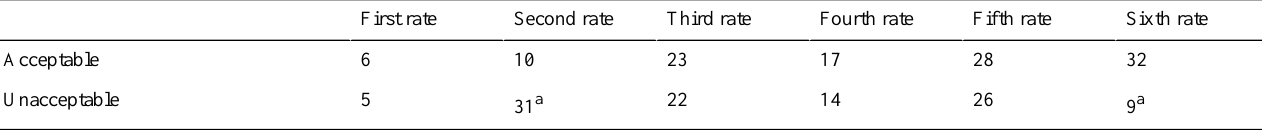
Table 5. Acceptable and unacceptable respiratory rate